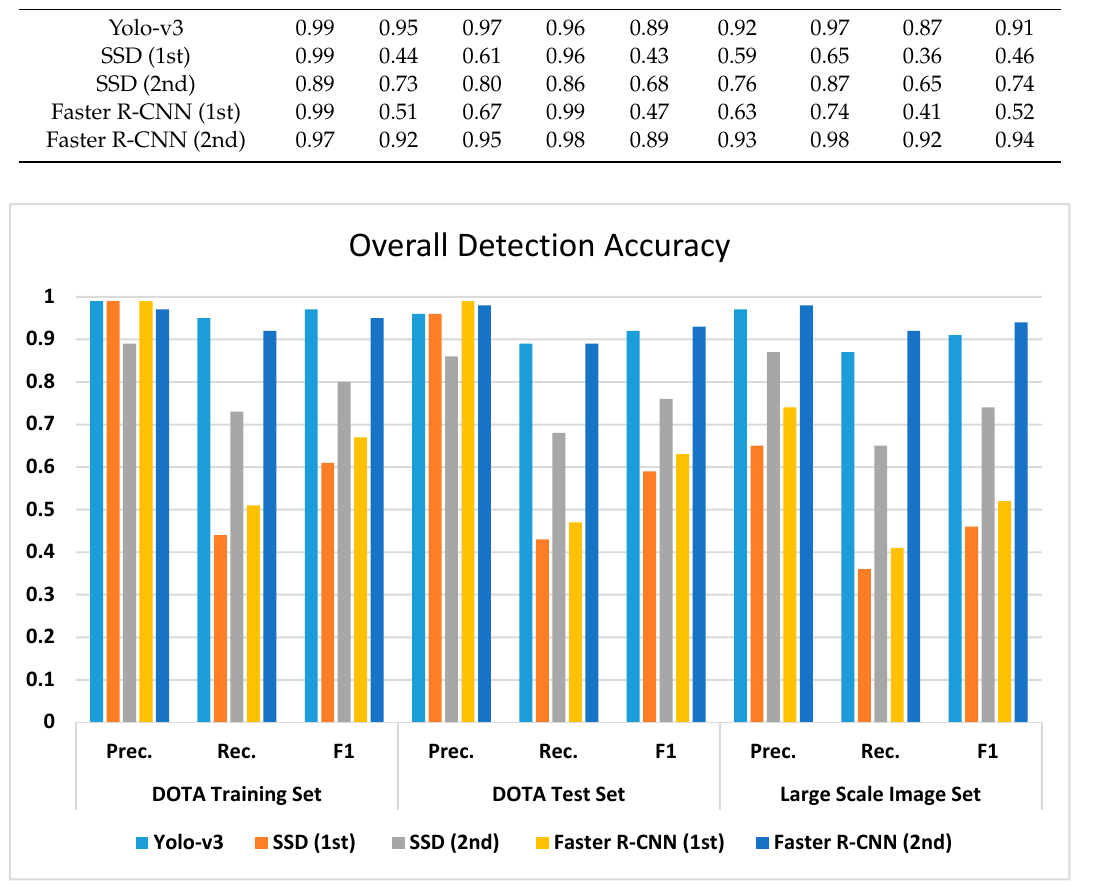
Figure 11. Graphic representation of the precision, recall, and F1 scores.